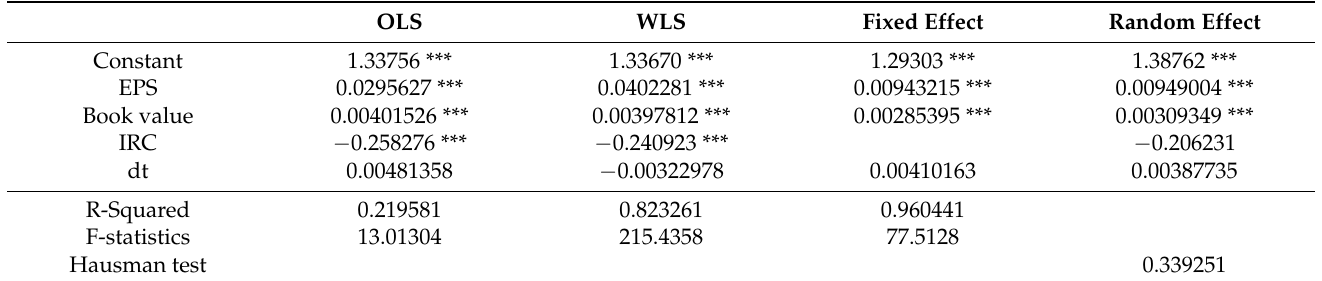
Table 3. Model’s